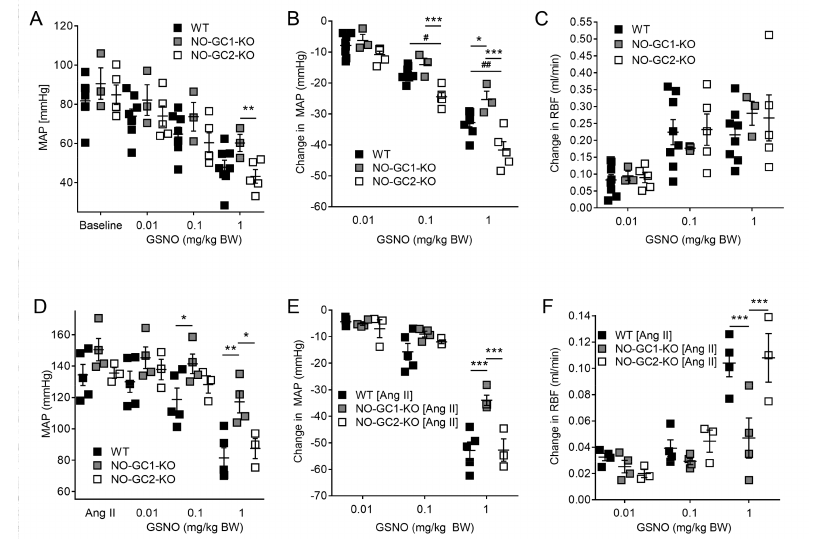
Figure 2. Predominant role of NO-GC1 in GSNO-induced blood pressure reduction and renal blood flow increase in anesthetized mice. ( A , B ) In normotensive mice, GSNO induced blood pressure reduction, expressed as absolute blood pressure values and blood pressure reduction, was attenuated in NO-GC1-KO ( n = 3) compared to WT ( n = 8) and NO-GC2-KO ( n = 5) mice; ( C ) In normotensive mice, GSNO-induced increase in renal blood flow did not differ between the three genotypes ( n = 3–8); ( D – F ) In Ang II-infused mice (200 ng/kg/min), GSNO-induced blood pressure reduction, expressed as absolute blood pressure values and blood pressure reduction, and renal blood flow increase were significantly attenuated in NO-GC1-KO ( n = 3) compared to WT ( n = 5) and NO-GC2-KO ( n = 4) mice. * p < 0.05, ** p < 0.01, *** p < 0.001 vs. NO-GC1-KO; # p < 0.01, ## p < 0.001 vs. NO-GC2-KO. Two-way ANOVA followed by Bonferroni’s multiple comparison post hoc